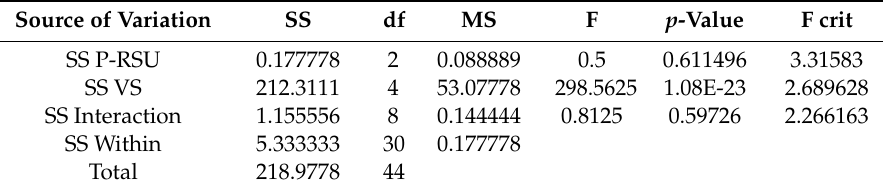
Table 5. ANOVA table for two factorial design.